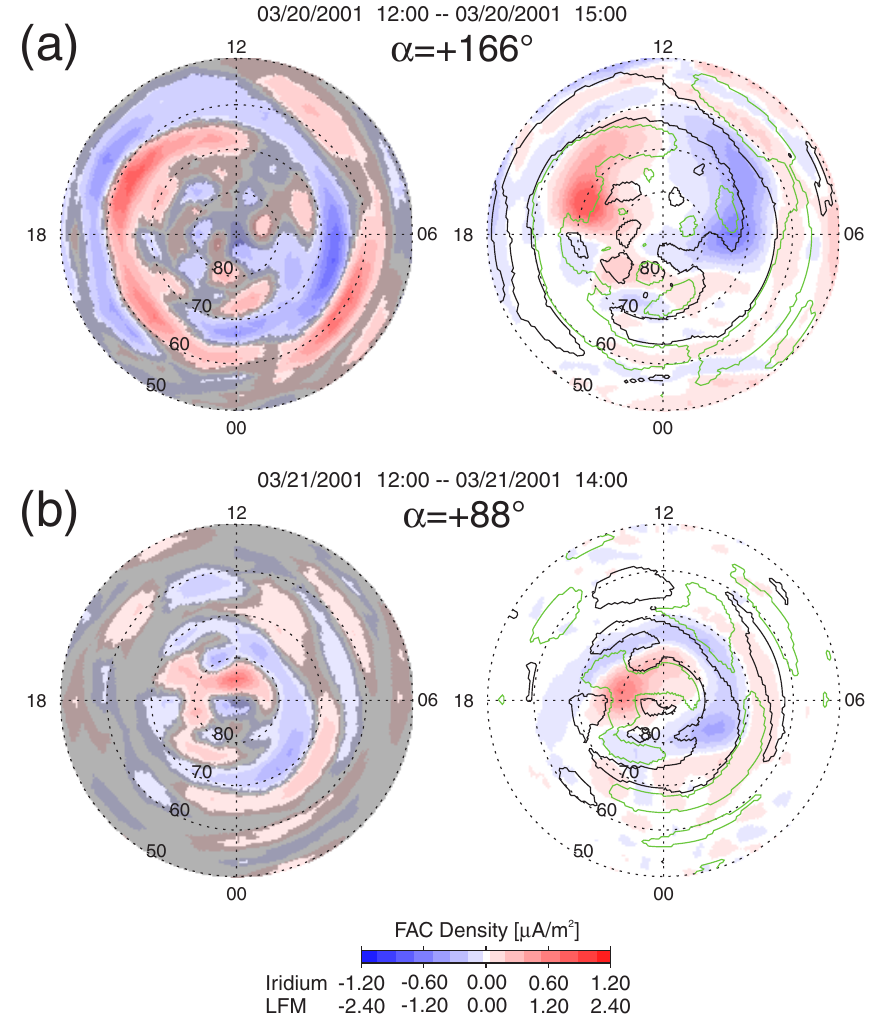
Fig. 5. Comparison of Birkeland current distributions observed during the 19–21 March 2001 magnetic cloud with LFM simulations results. Downward and upward currents are represented by the colors blue and red,